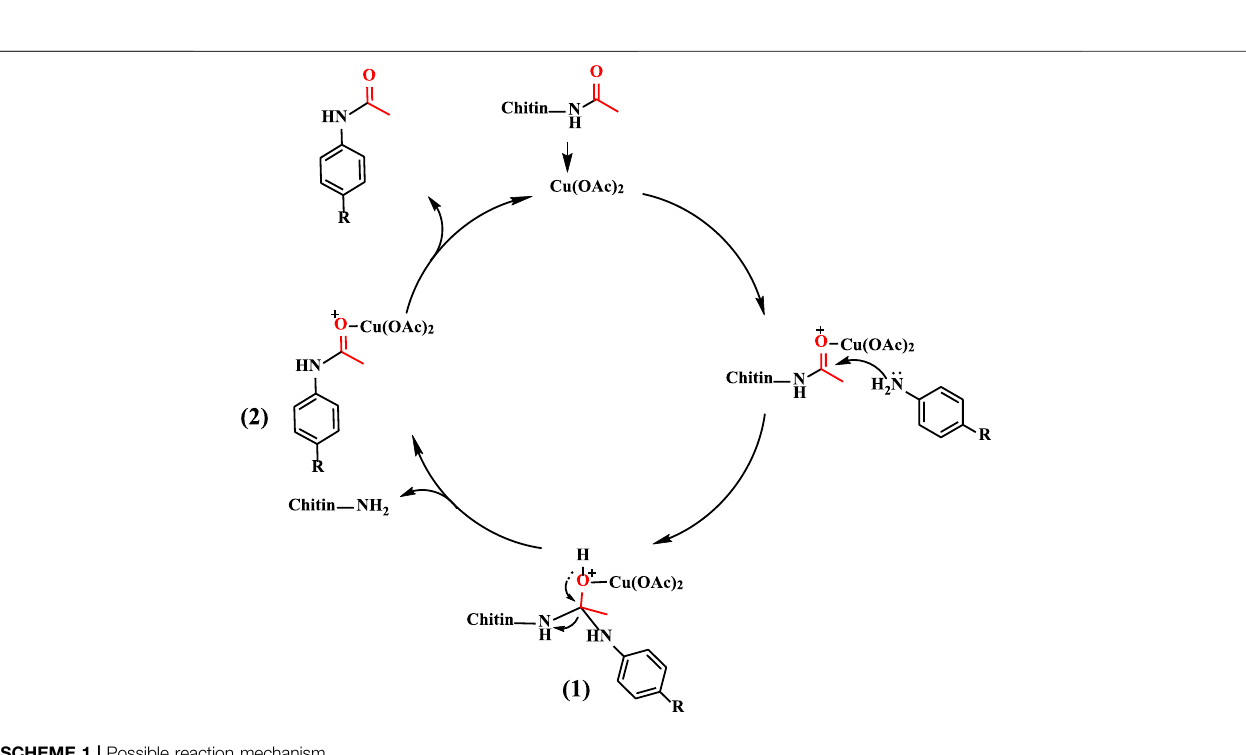
SCHEME 1 | Possible reaction